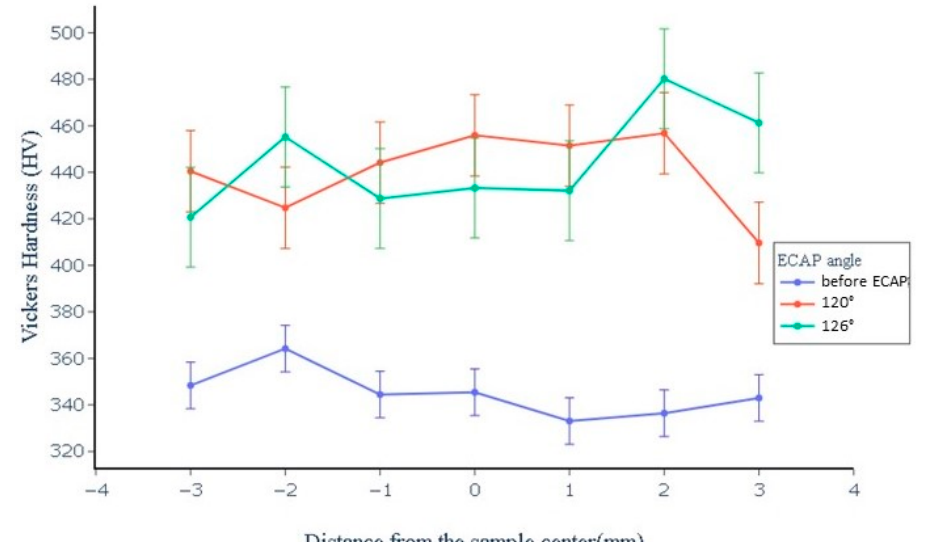
Figure 3. Hardness profile of SS316L samples.